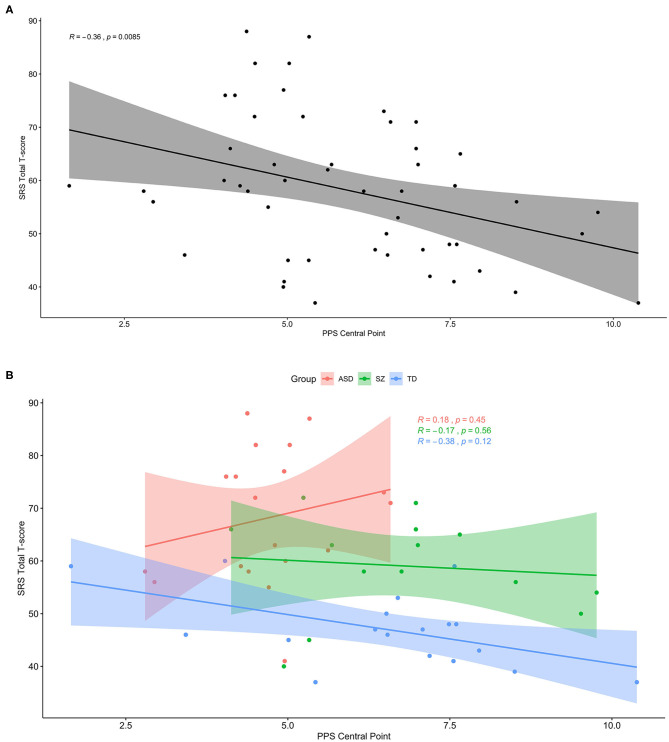
Smaller PPS is associated with more social-communication deficit, but only in the subclinical range. (A) Across the whole sample, greater social-communication deficits as measured by the total T score of the SRS-2 was associated with smaller peripersonal space (PPS). (B) The same plot with groups separated by color (ASD: red, SZ: green, TD: blue), showing a trendline similar to that for the whole sample only within the TD group.